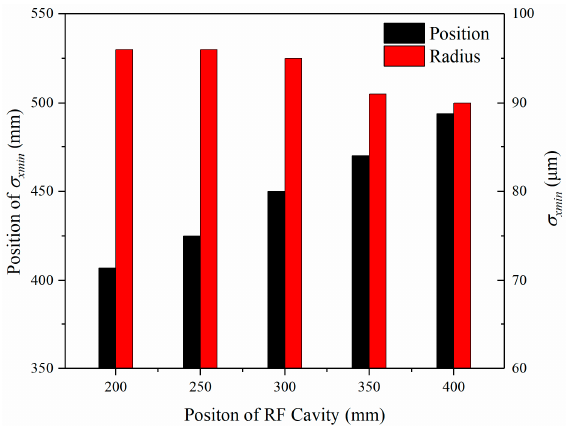
Figure 8. Focus radius 𝜎 (cid:3051)(cid:3040)(cid:3036)(cid:3041) evolves with various positions of the RF cavity.